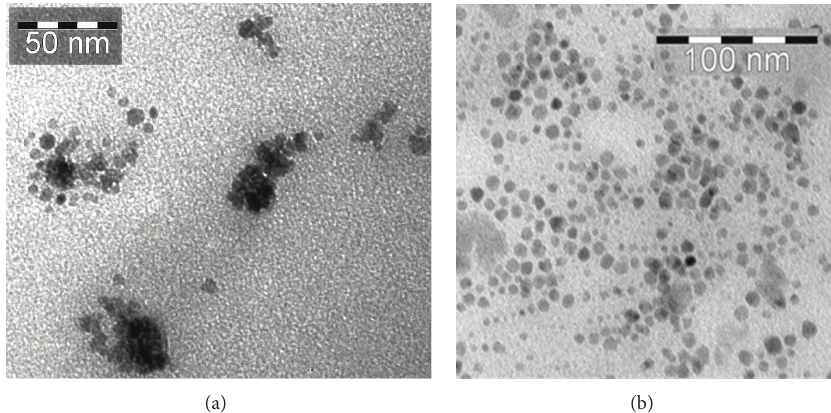
Figure 3: TEM images for (a) Nanomag-D-SPIO and (b) SPIONs-C595 antibody binding causes a significant reduction of particle agglomeration. The average particle size of particles estimated from TEM images was about 10–20 nm.